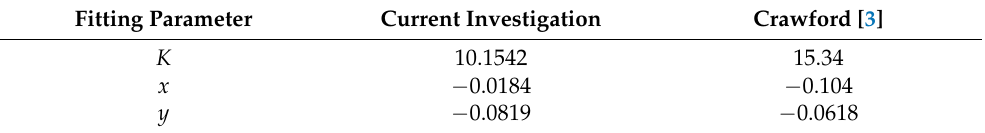
Table 1. Fitting parameters for Equation